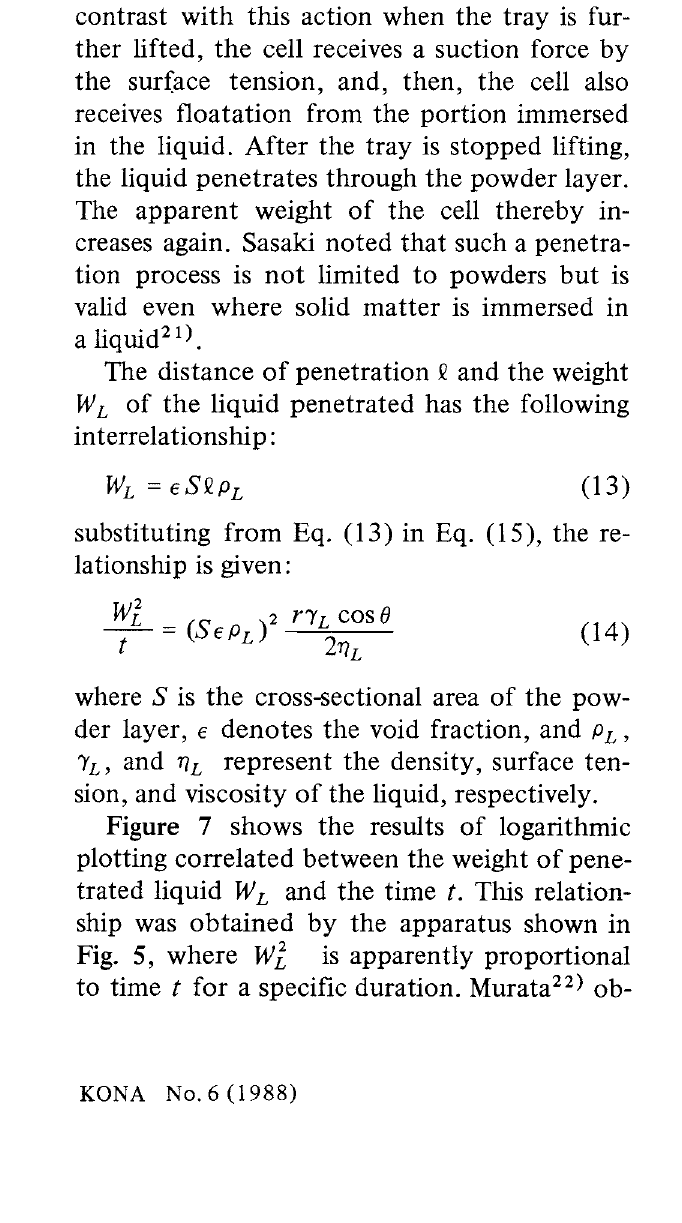
Fig. 8 Comparison of penetrated liquid levels by visual observation and by using the weighing method